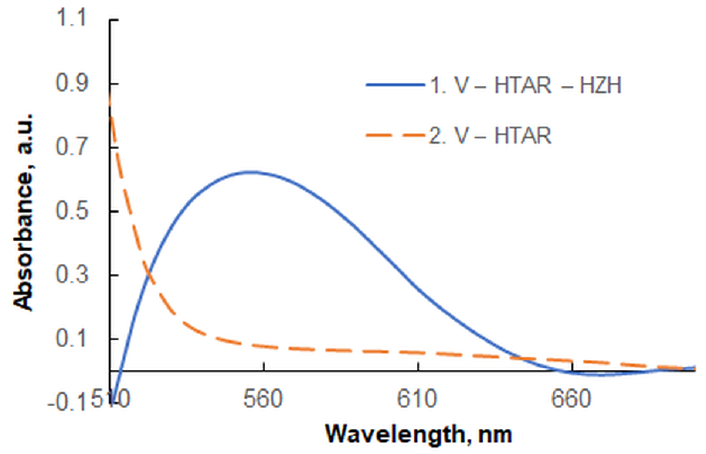
Figure 2. Absorption spectra in chloroform of the V(V)-HTAR-HZH complex (1) and the blank V(V)- HTAR (2); 3 × 10 −5 mol L −1 of V(V), 2.4 × 10 −4 mol L −1 of HTAR, 1.7 × 10 −5 mol L −1 of HZH, pH of 4.3 (ammonium acetate buffer), extraction time of 45 s.